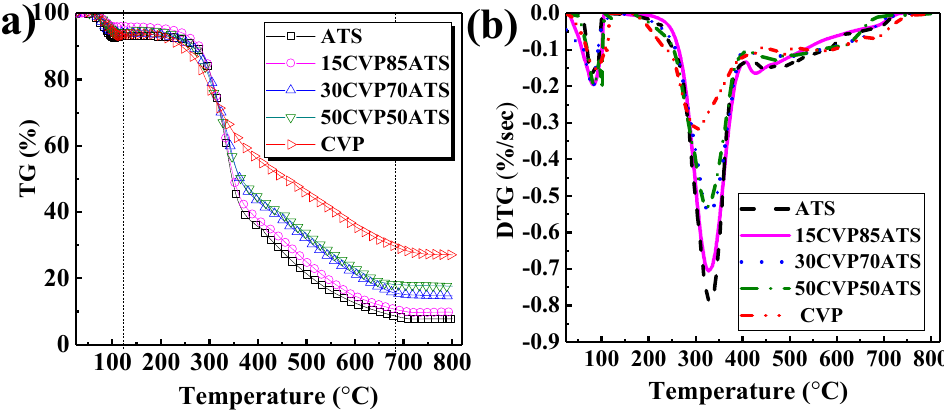
Figure 8. ( a ) Thermogravimetric, and ( b ) DTG curves of all samples (CSB) heated at a rate of 30 °C/min.